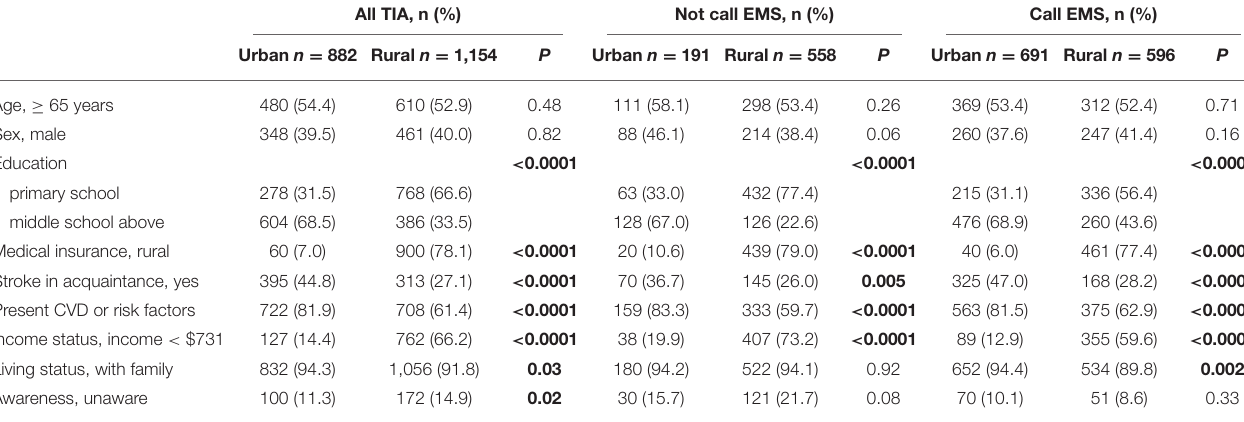
TABLE 2 | Urban–rural difference in characteristics distribution among all TIA participants and by intention to call EMS. All TIA, n